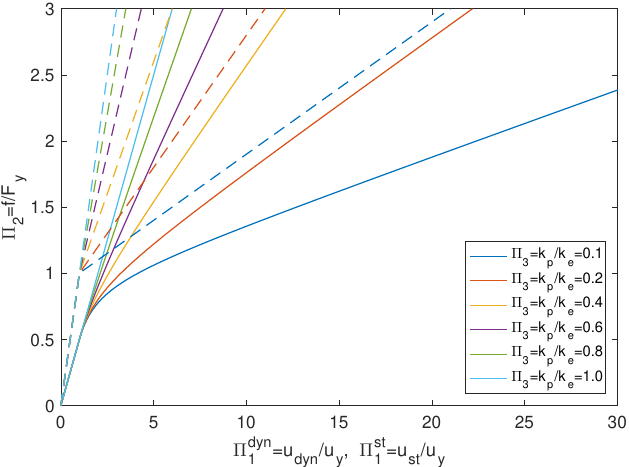
Figure 4. Loading force - displacement curves for various values of Π 3 . Continuous lines relates to the dynamic analysis, that is, Π dyn , while the dashed lines relate to the quasi-static loading, that is, Π st 1